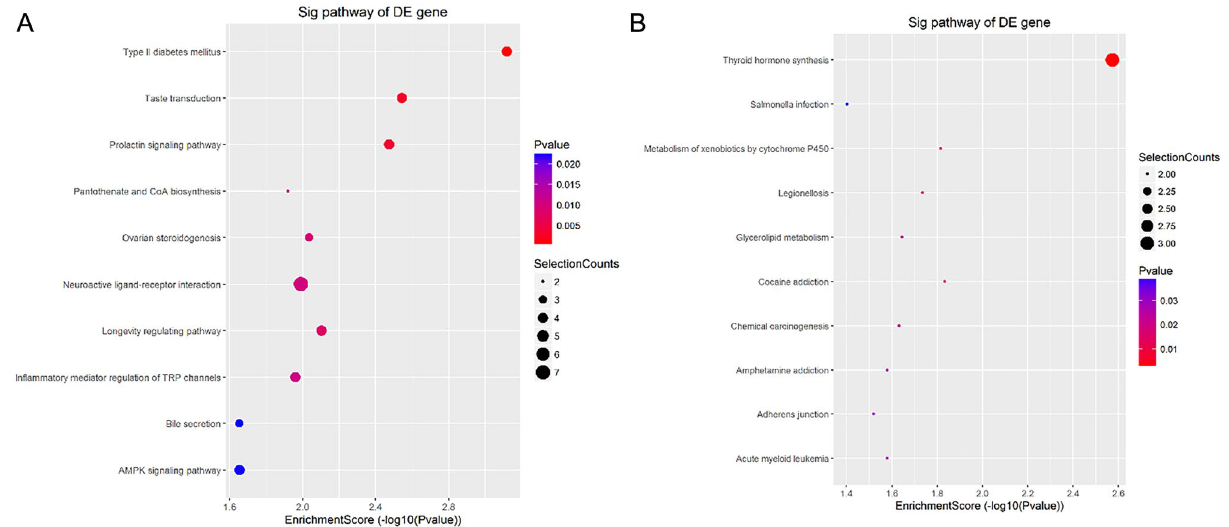
Figure 6. Pathways analyses for the differentially expressed genes (DEGs) analysed by Kyoto Encyclopedia of Genes and Genomes (KEGG). ( A ) The top ten pathways with upregulated Enrichment Score Dot Plot. ( B ) The top ten pathways with down-regulated Enrichment Score Dot Plot.